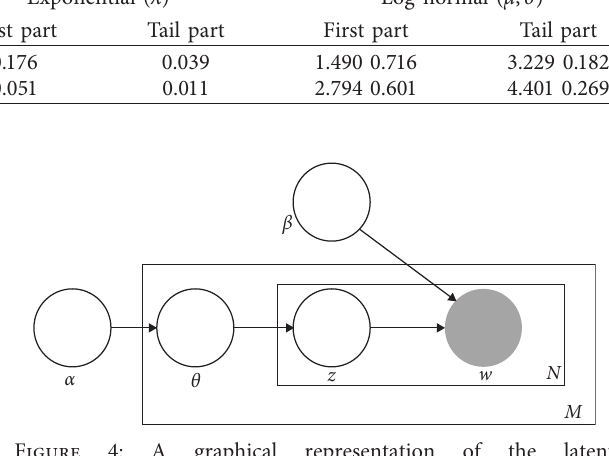
Figure 4: A graphical representation of the latent Dirichlet